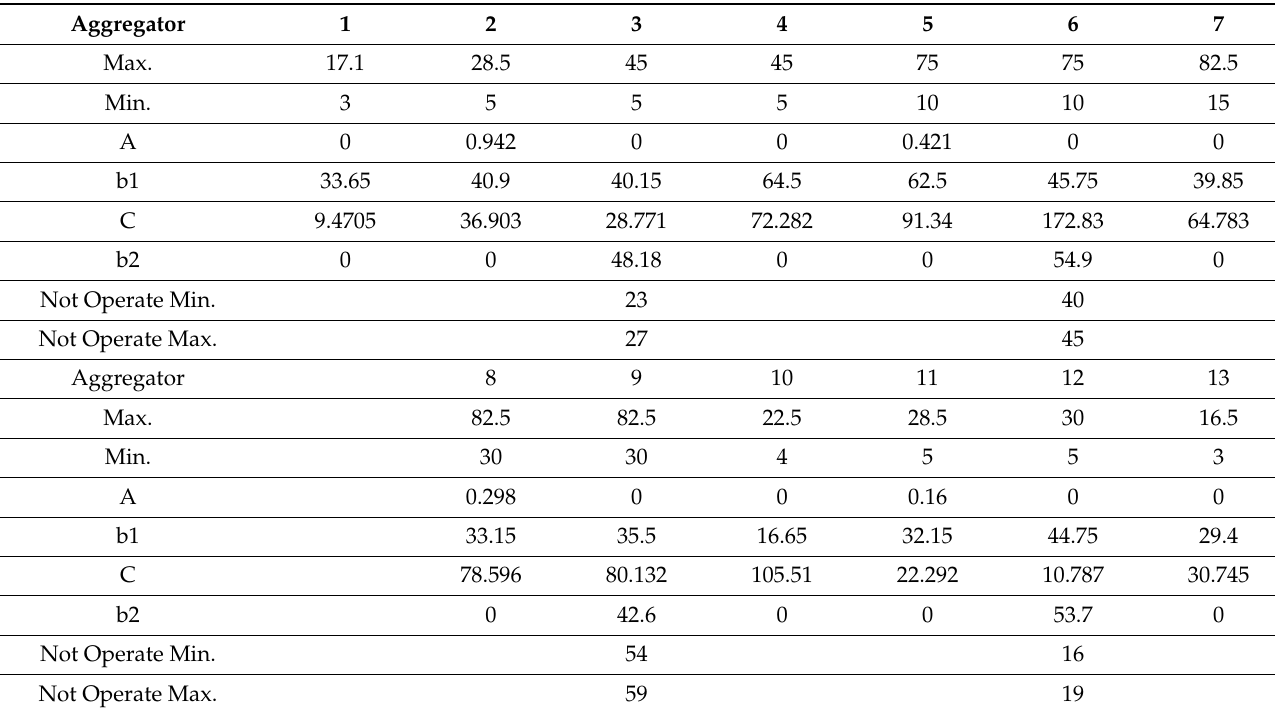
Table 6. Bidding curves of the different user aggregators.